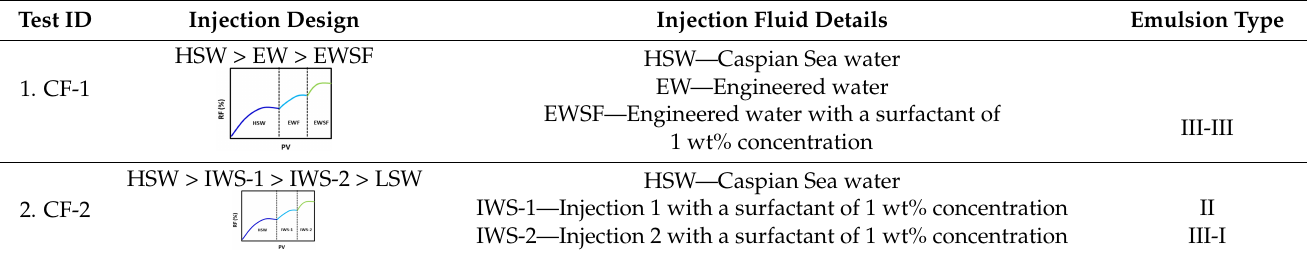
Table 5. Design of oil displacement tests for hybrid LSSF with different salinity profiles. Test